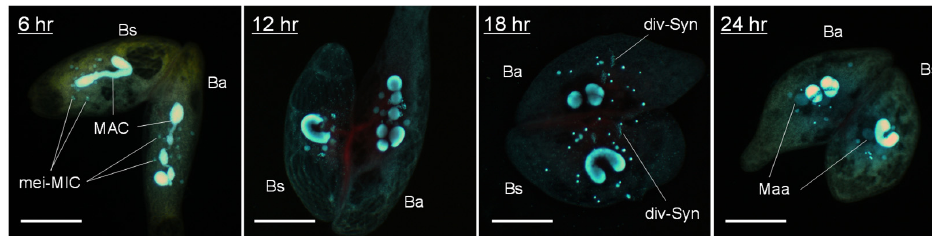
Figure 4. Inter-species ( B. americanum – B. stoltei ) conjugating pairs stained with DAPI as described in Materials and Methods. Ba: B. americanum (with multinodal macronucleus); Bs: B. stoltei (with filiform macronucleus); mei-MIC: meiotic micronuclei; MAC: macronucleus; div-Syn: division of synkaryon; Maa: macronuclear anlagen. Scale: 50 µm.